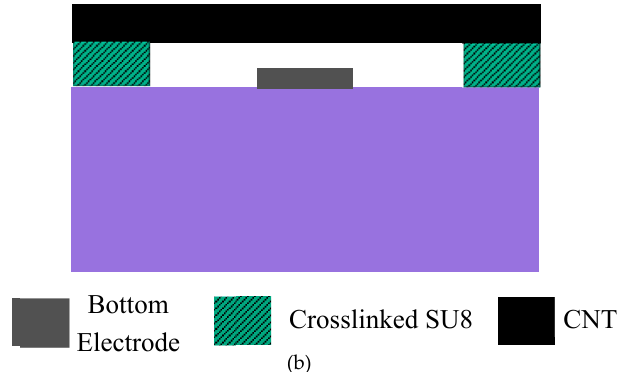
Figure 1. ( a ) Schematic of thefabrication process. Reprinted with permission from [25], and ( b ) Schematic of the cross section of the device.